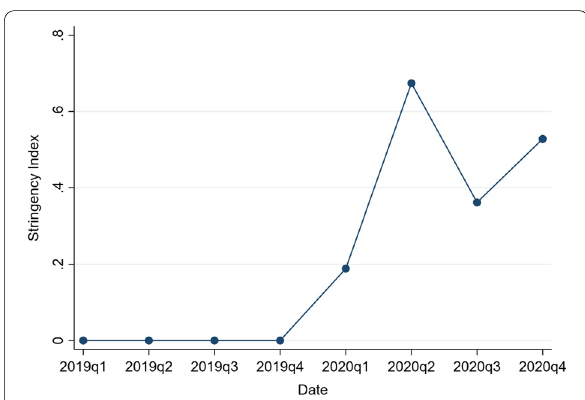
Fig. 2 KOF stringency index. Notes This index record the stringency of COVID-19 policy measures in Switzerland. It is constructed as the (population) weighted average of the cantonal indexes. The